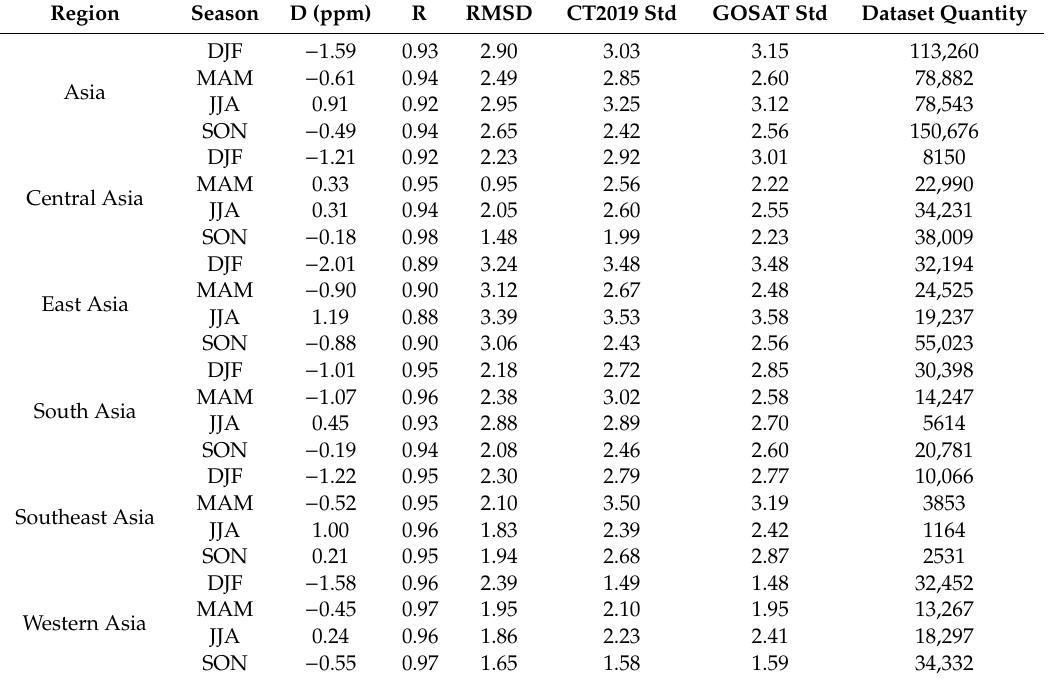
regions. The statistics are based on the seasonal average of the di ff erence between the CT and GOSAT (D), correlation, Route Mean Square Deviation (RMSD), and the standard deviation. Region